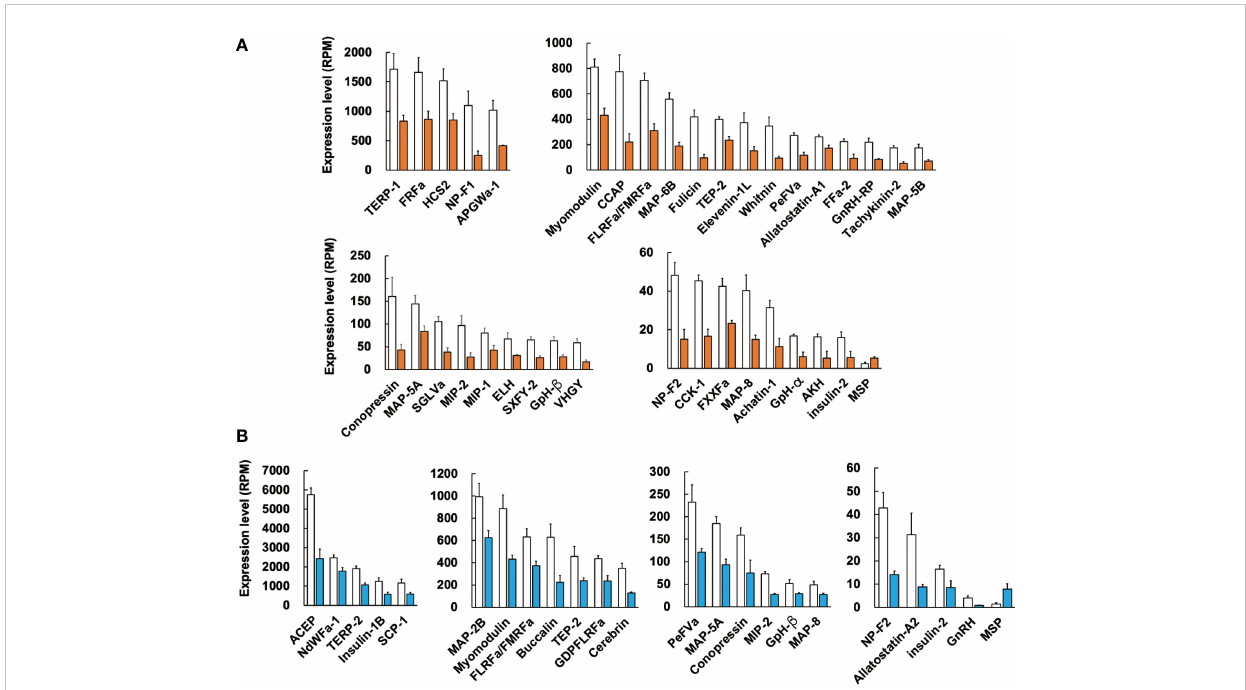
FIGURE 4 Difference in expression levels of neuropeptide precursors between the normal and CSM snails. RPM of identi fi ed neuropeptide precursors in female (A) and male (B) were compared between the normal and CSM snails, and precursors with statistically signi fi cant change ( p < 0.05 by student ’ s t -test) are indicated. Note that expression of MSP precursor was up-regulated, while other precursors are down-regulated. For the abbreviated names of neuropeptides, refer to Table S3. Each column and vertical bar represent mean RPM ± S.E. (n = 3), respectively. Open columns: normal snail, colored columns: CSM